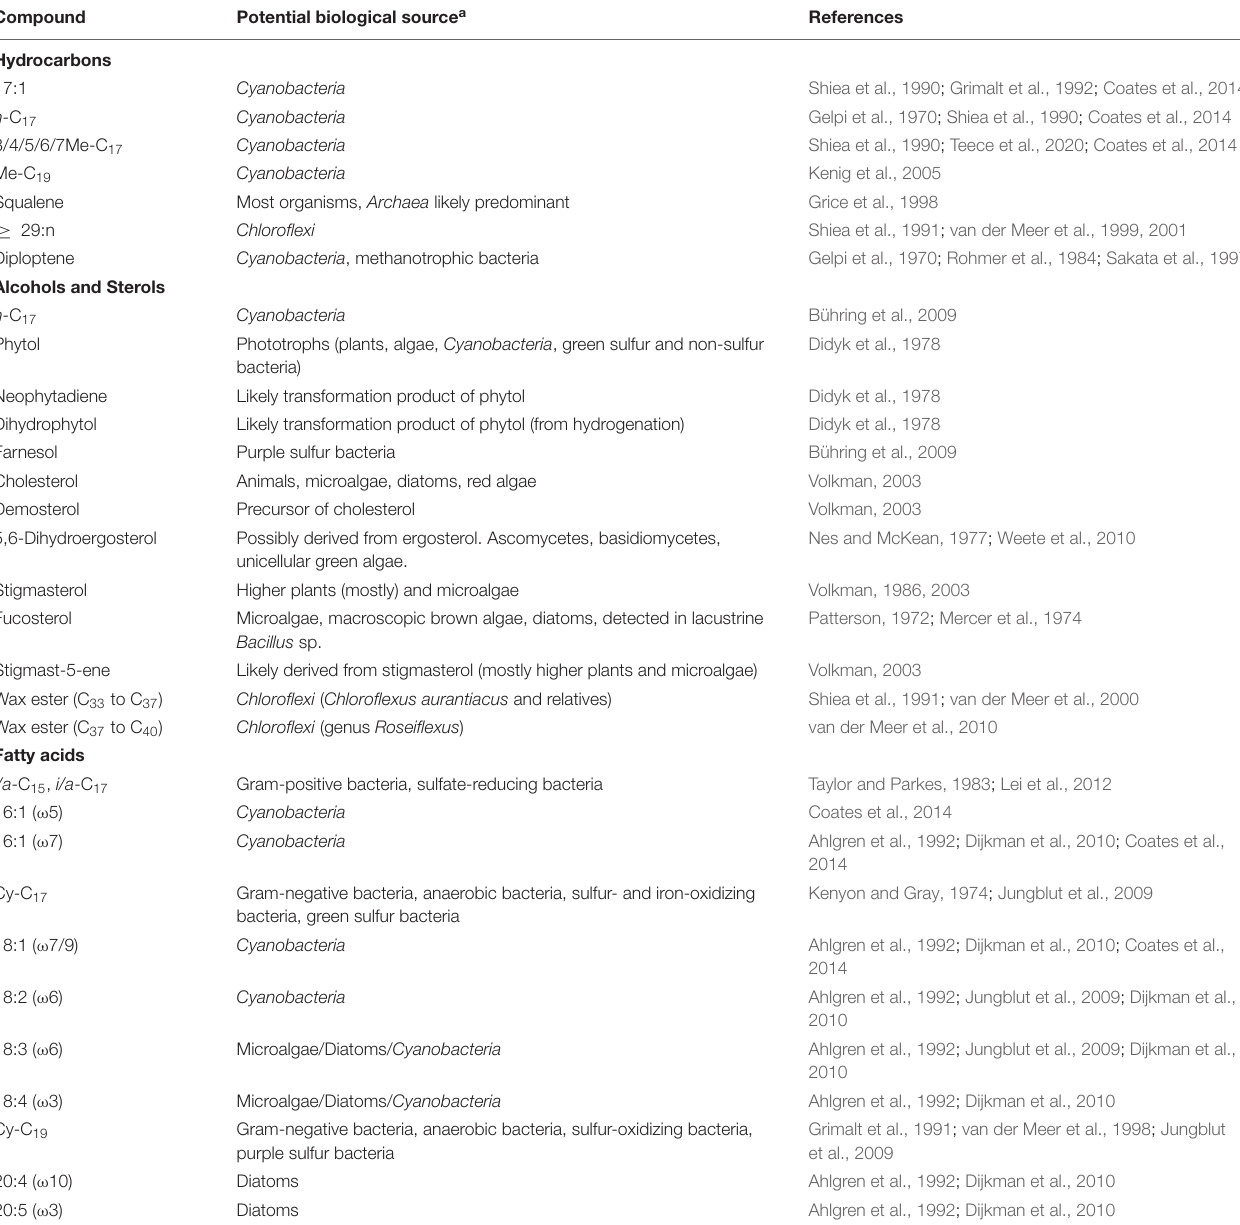
TABLE 4 | Potential biological sources of lipidic molecules isolated from the Cacao stream biofilms. Compound Potential biological source